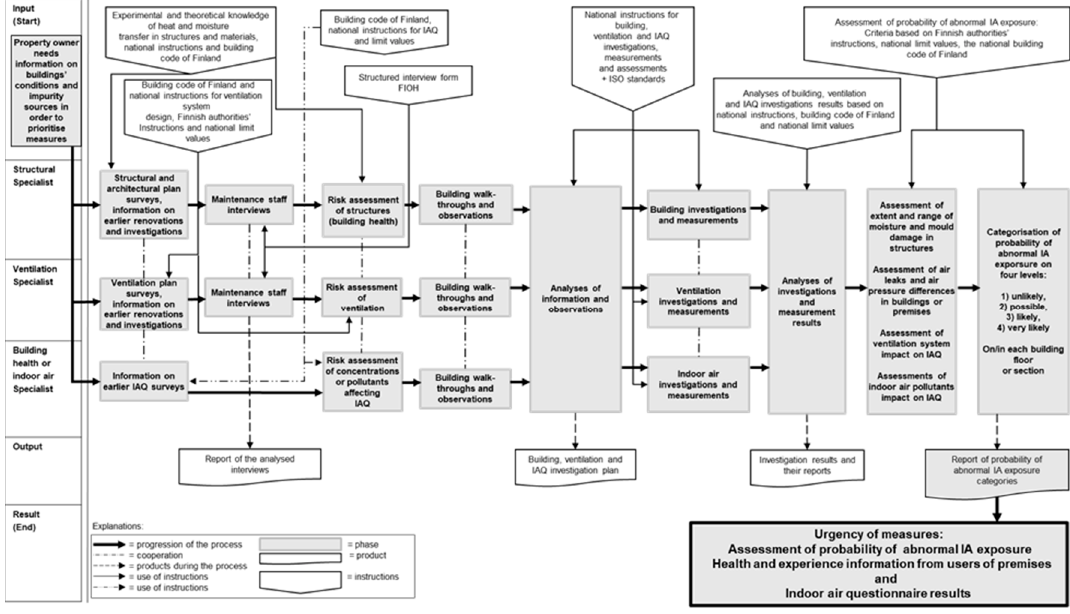
Figure 1. Process for assessing the probability of abnormal indoor air (IA) exposure [25].